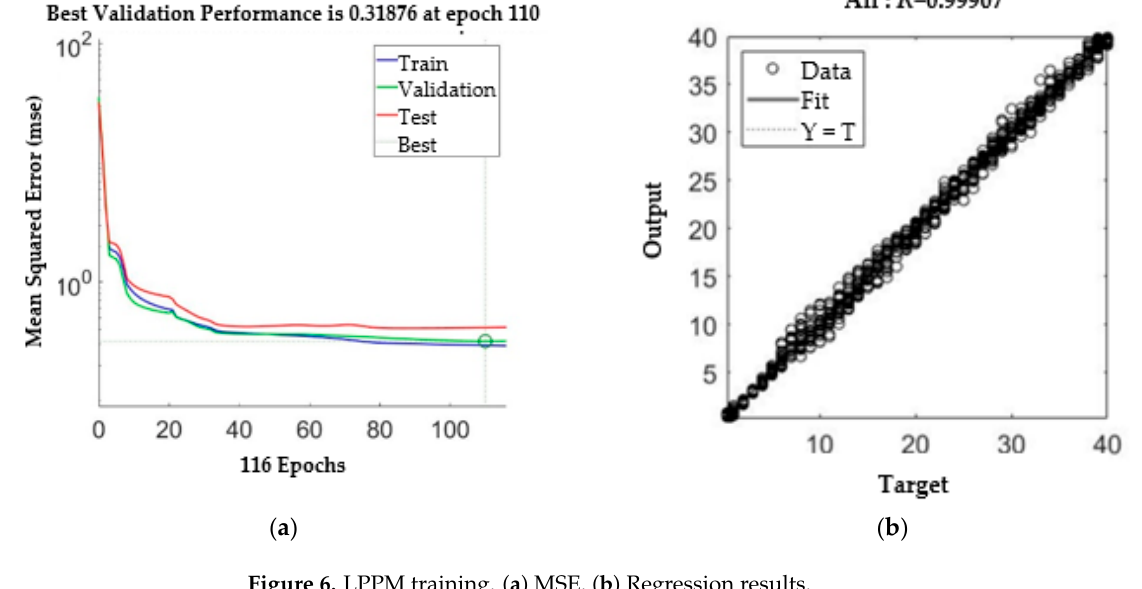
Figure 6. LPPM training. ( a ) MSE. ( b ) Regression results.